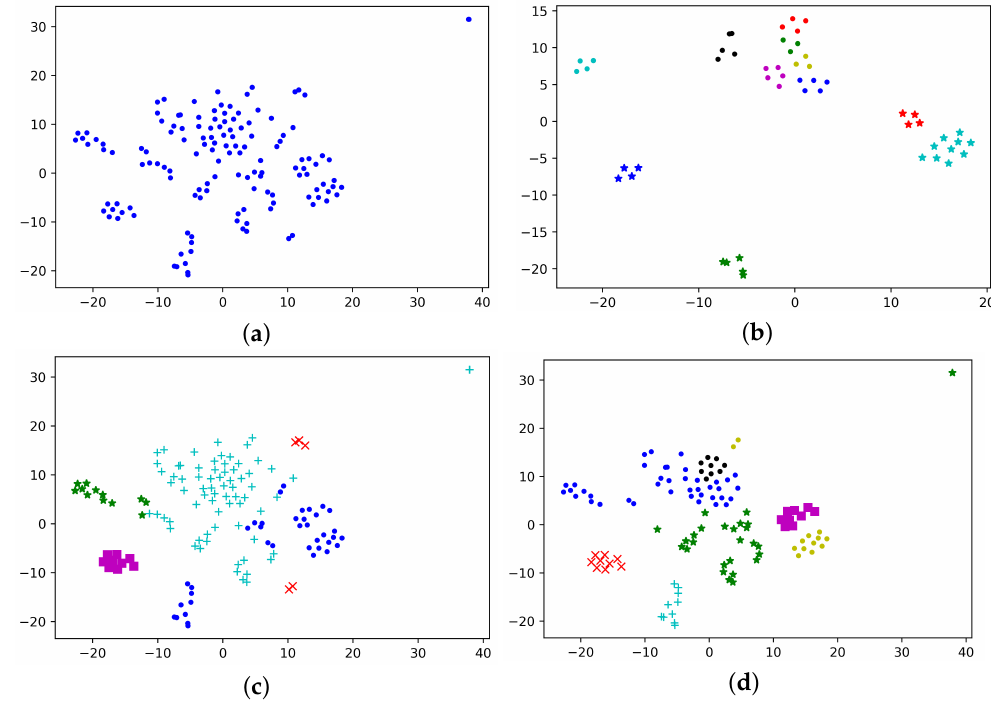
Figure 9. Comparison of clustering effects between the ACBD algorithm and DBSCAN algorithm. ( a ) Differential frame distribution. ( b ) DBSCAN algorithm clustering results. ( c ) K-means algorithm clustering results. ( d ) ACBD algorithm clustering